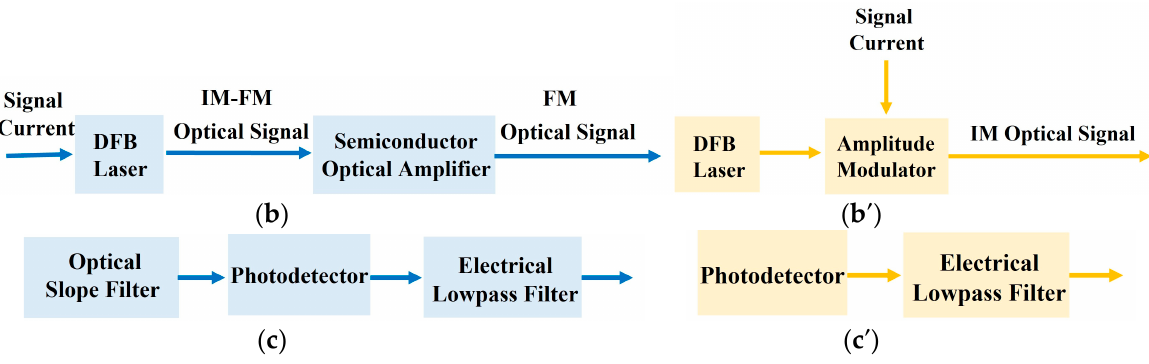
Figure 1. Schematic representation of ( a ) a long-reach DWDM-PON, whose transmitters and receivers are shown in ( b , c ) for the proposed FM-NCD scheme and in ( b ′ , c ′ ) for the conventional IM-DD scheme for comparison.